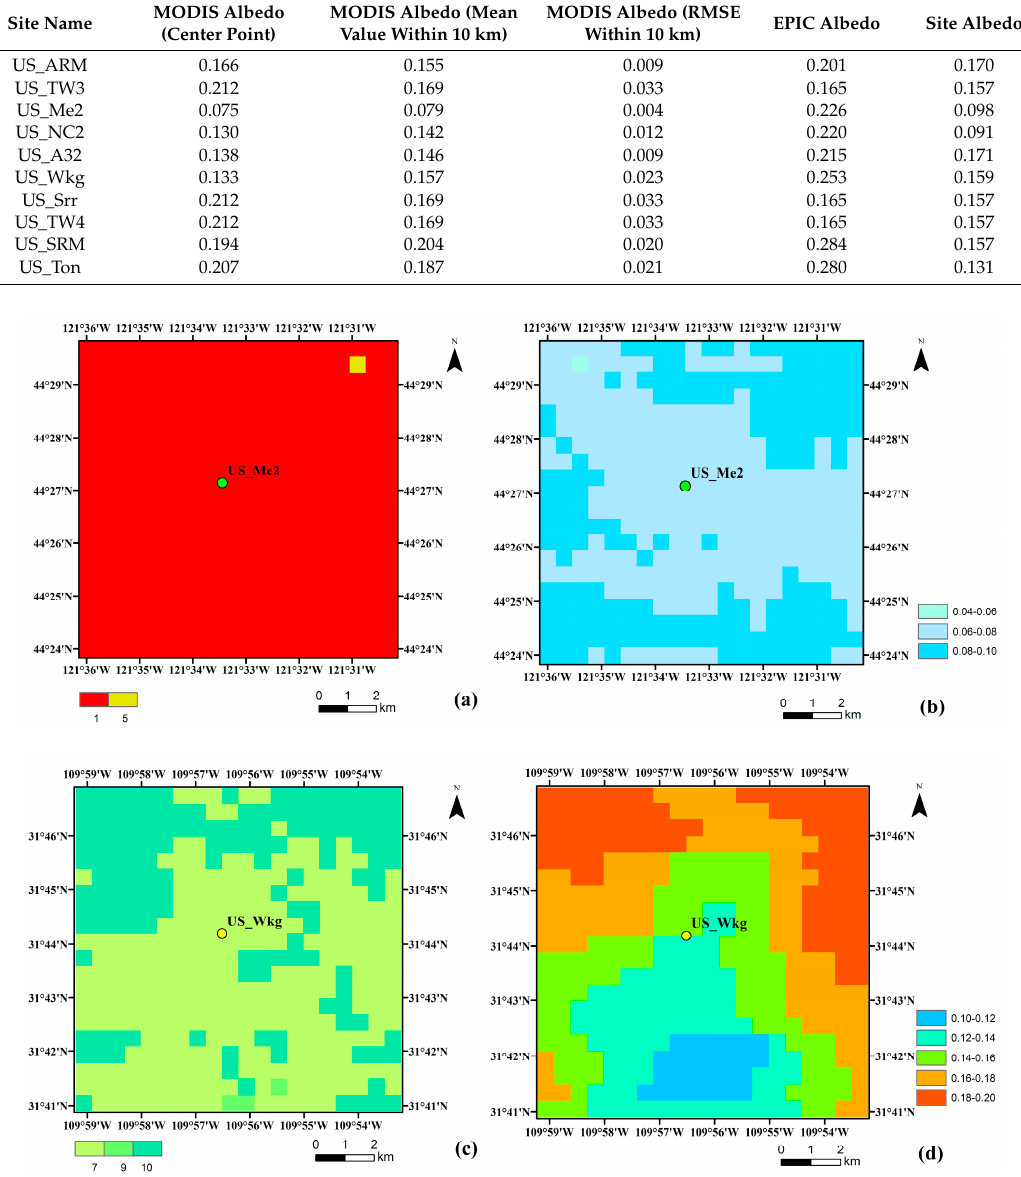
Figure 7. Land cover map from MCD12Q1 ( a ) and MCD43A3 blue-sky albedo ( b ) over US_Me2, land cover map ( c ) and MCD43A3 blue-sky albedo ( d ) over US_Wkg on 4th June, 2016. 1 indicates that the land cover type is ENF (evergreen needleleaf forests), 5: MF (mixed forests), 7: OSH (open shrublands), 9: SAV (savannas), 10: GRA (grasslands). The AmeriFlux sits are located at the center of each map.